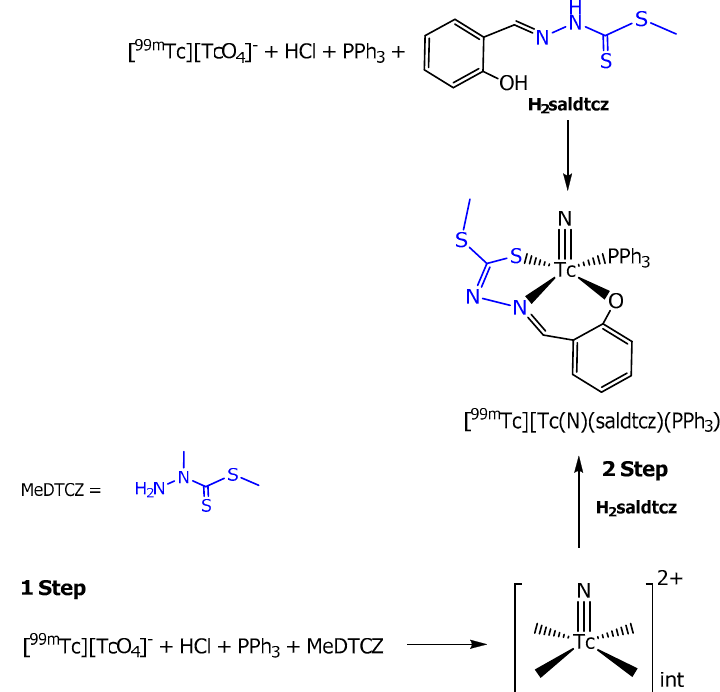
Figure 10. Reaction scheme for the synthesis of the [ 99m Tc][TcN(saldtcz)(PPh 3 )] complex.